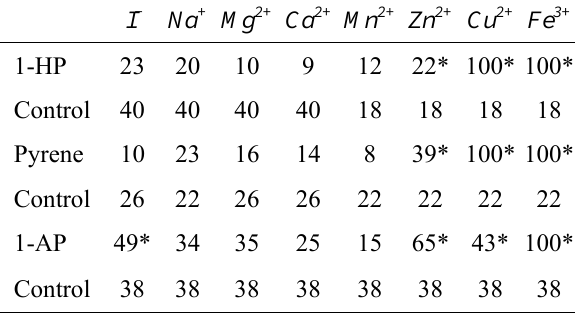
Table 1: Effect of biologically relevant ions on the percent of DNA photocleavage by 1-hydroxypyrene (1- HP), 1-aminopyrene (1-AP), and